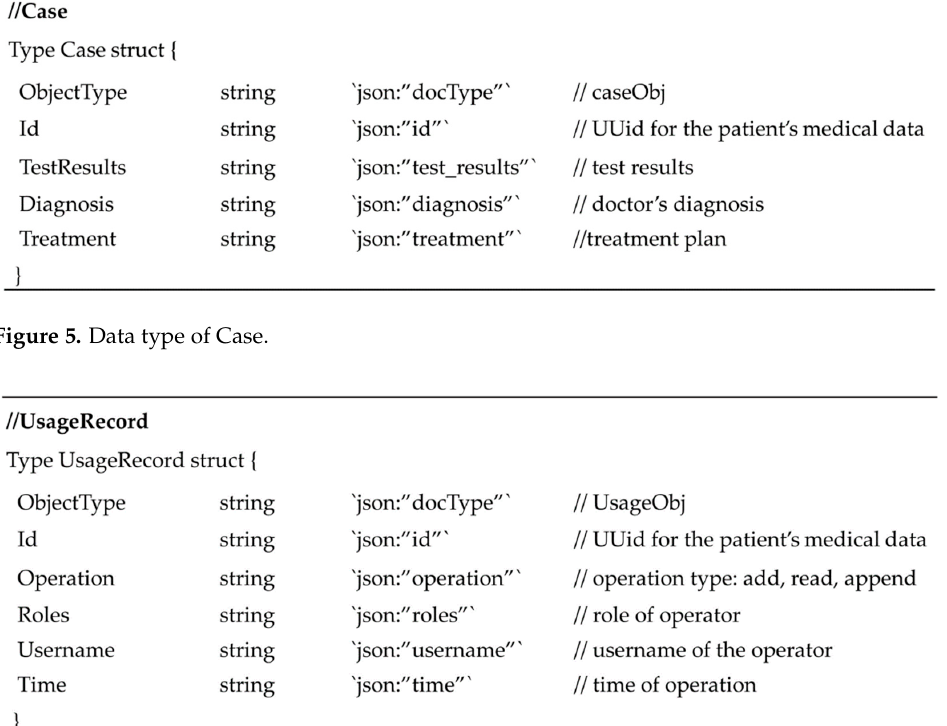
Figure 6. Data type of usageRecord.